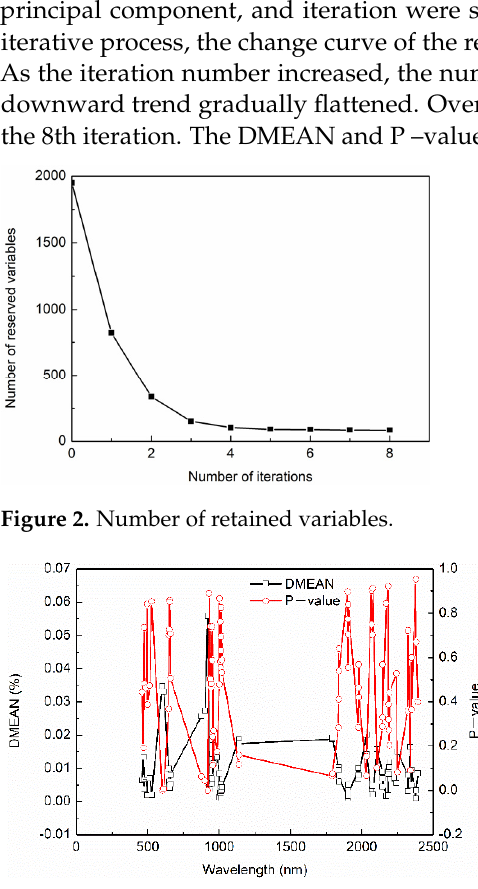
Figure 4. Selection of characteristic wavelength using IRIV based on open-field cultivation. The number of selected characteristic wavelengths using the IRIV algorithm was high. For further data dimensionality reduction, SPA was used to perform an extraction of characteristic wavelengths for the second time based on 71 extracted characteristic wavelengths using IRIV. When the RMSE was 1.0257%, 10 characteristic wavelengths were extracted. According to the degree of importance, the extracted wavelengths using IRIV-SPA were 957, 1008, 2339, 920, 2248, 2394, 1137, 1976, 647, and 602 nm in turn. Based on extracted characteristic wavelengths using IRIV and IRIV-SPA, LS-SVM was used to establish SSC detection models. The SSC of fresh jujubes from two cultivation modes was predicted. The SSC-predicted results are shown in Table 4. Table 4. Prediction results of SSC using IRIV and IRIV-SPA. Variable Selec- tion Methods